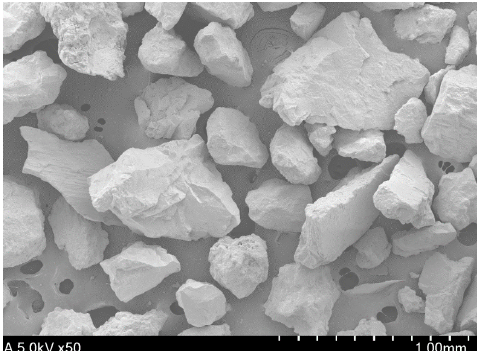
Figure 1. SEM image of sand obtained from Nakdong River.